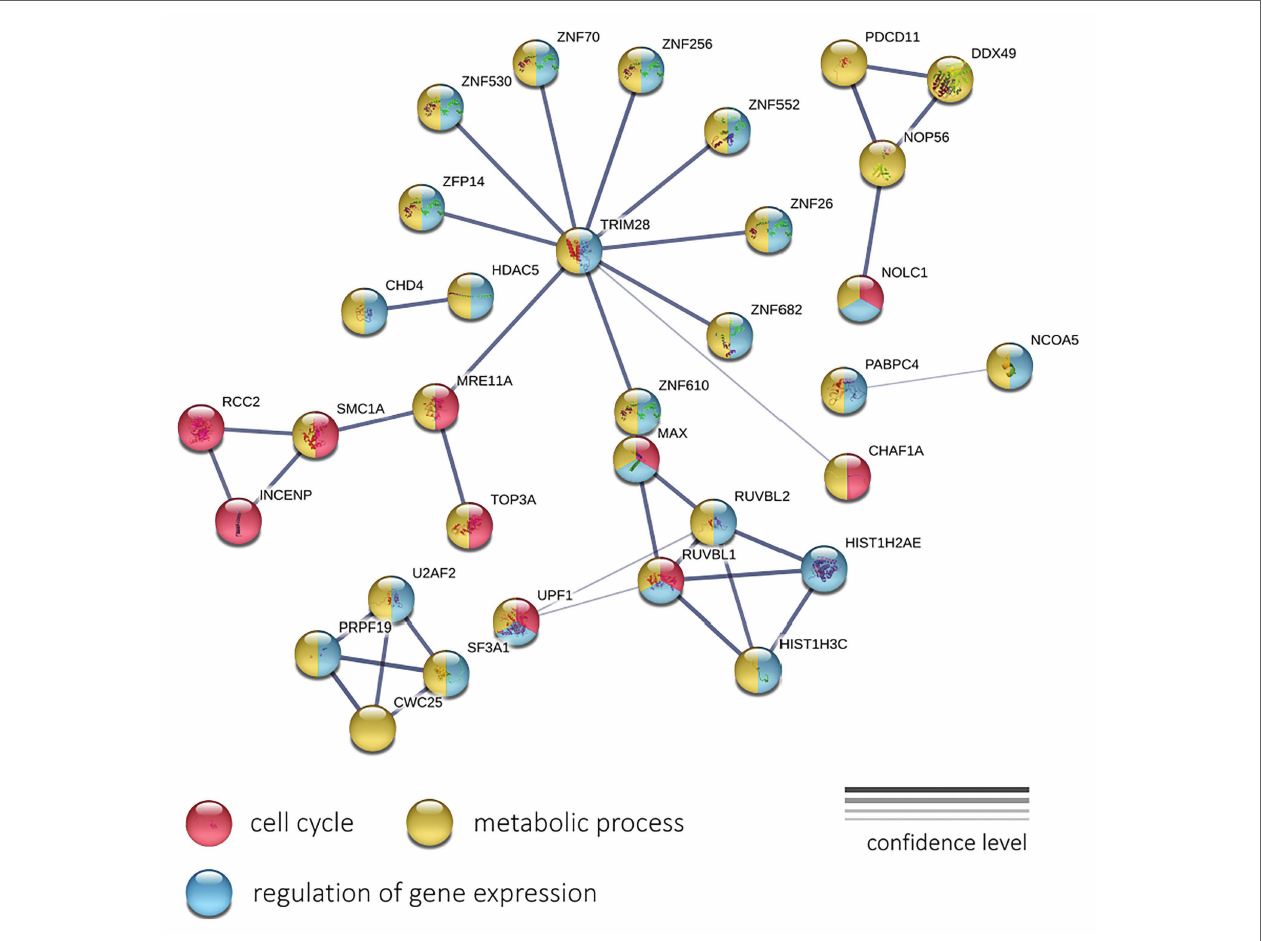
FIGURE 6 | The protein-protein interaction network of 196 genes with a significant negative expression correlation with PFS in CRPC. Circle colors indicate proteins participating in the cell cycle regulation (red), metabolic process (yellow), and regulation of gene expression (light blue). The thickness of lines indicates the reliability of evidence of the interaction between two proteins (direct or indirect experimental confirmation, predictions from homologues,